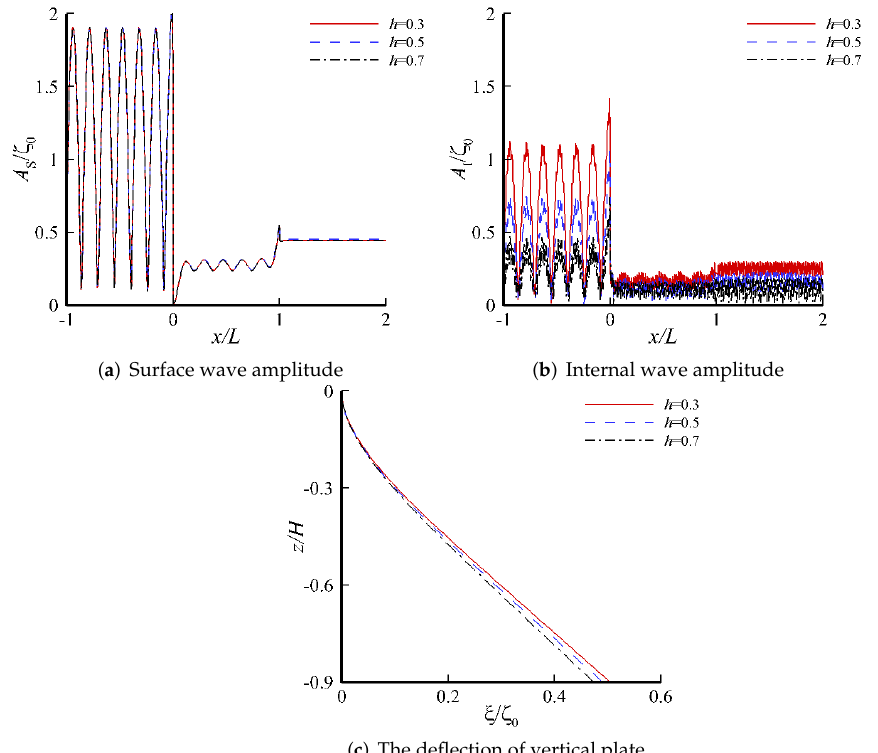
Figure 14. Wave amplitudes A S ( x ) , A I ( x ) , and deflection of vertical plate ξ ( z ) for the different depth ratio h